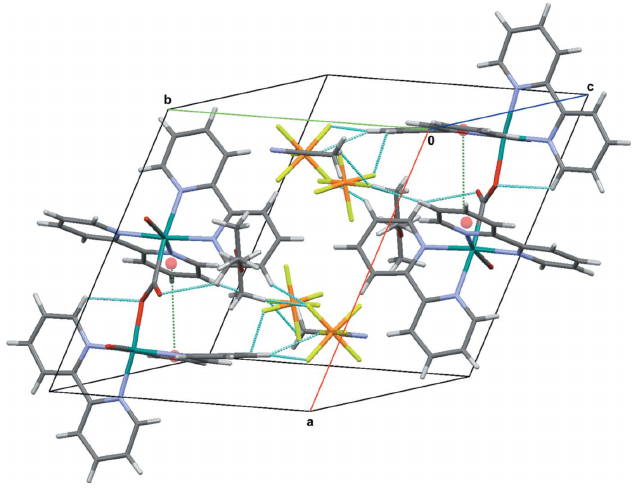
Figure 2 The crystal packing of the title compound. C—H (cid:3)(cid:3)(cid:3) O and C—H (cid:3)(cid:3)(cid:3) F hydrogen bonds (blue) and (cid:4) – (cid:4) contacts (green) are shown as dashed lines (for numerical details, see Table 2). Ring centroids are shown as red spheres. Only the major component of the disordered PF 6 (cid:2) anion is shown.